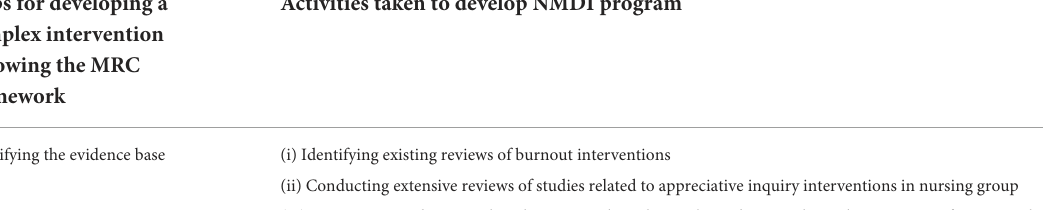
TABLE 1 Activities for developing NMDI program following the guidelines of the MRC. Steps for developing